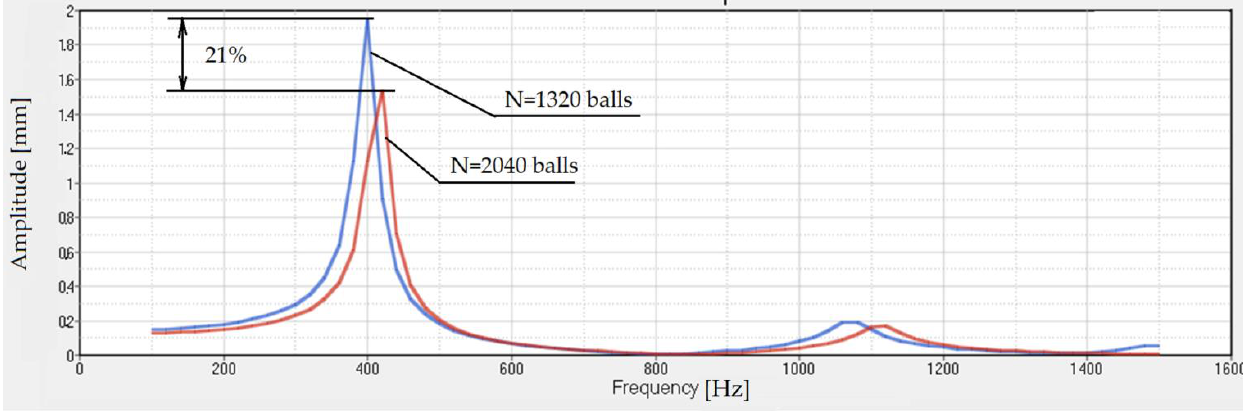
Figure 14. Comparasion Transmissibility for structural damping 6%.